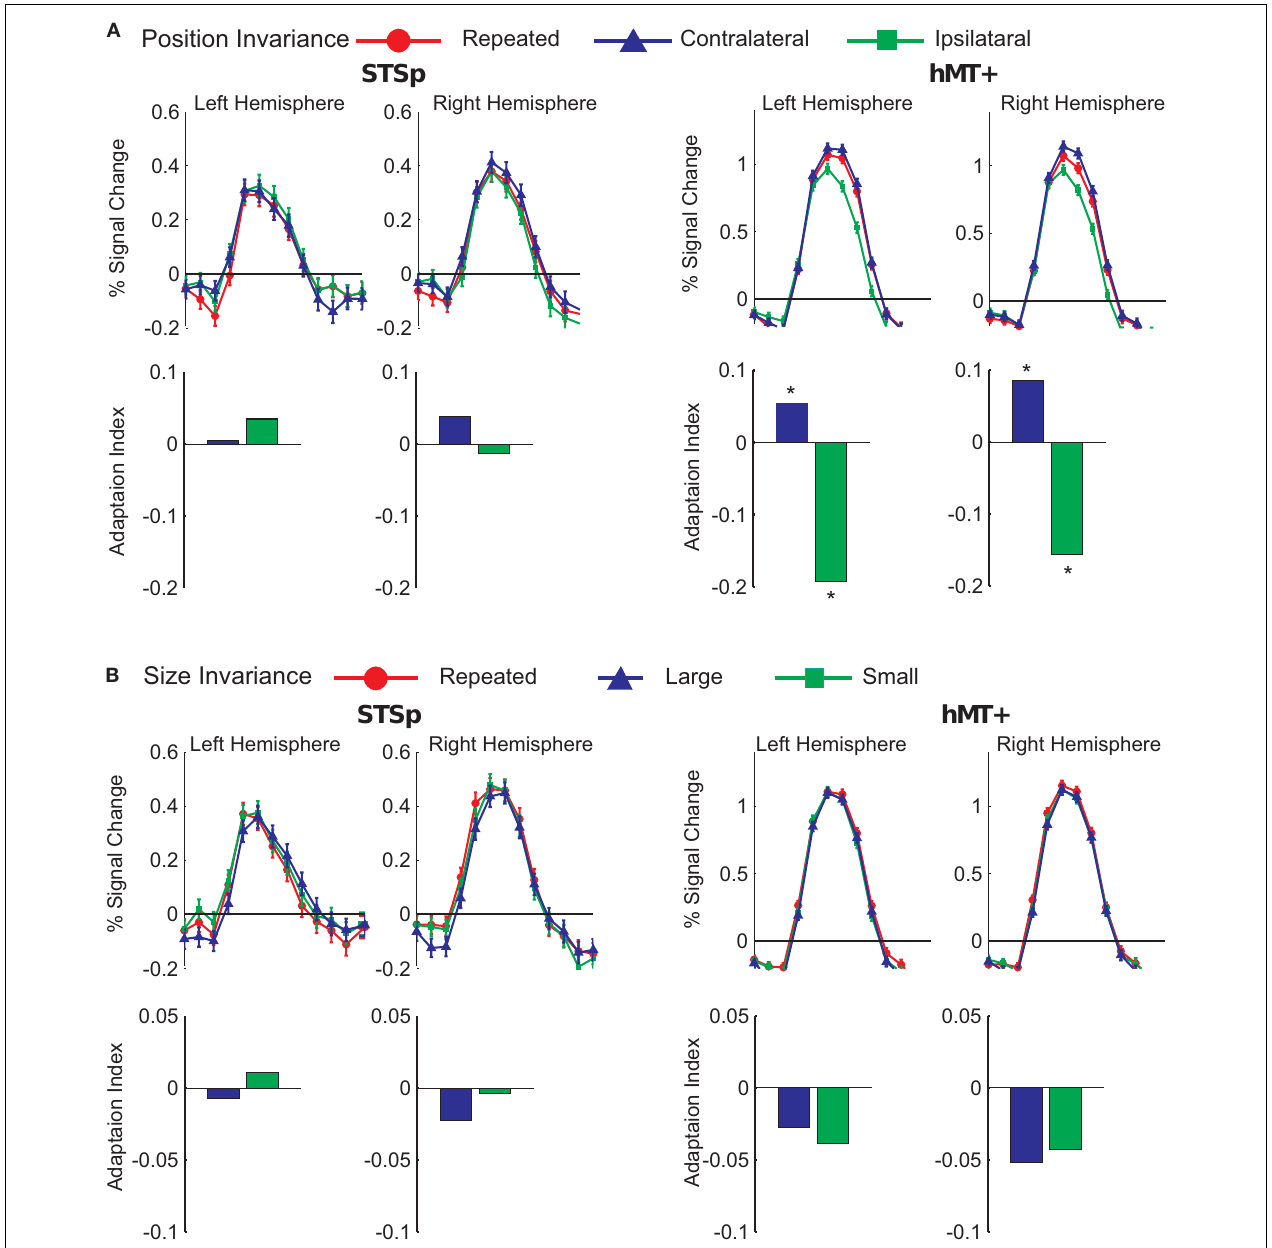
FIGURE 5 | Average deconvolved hemodynamic response functions and the corresponding adaptation indices for each hemisphere of the STSp and hMT + for (A) position changes and (B) size changes. *Indicates statistically signifi cant peak response from the Repeated (foveal or medium) condition, as computed from the deconvolved hemodynamic response